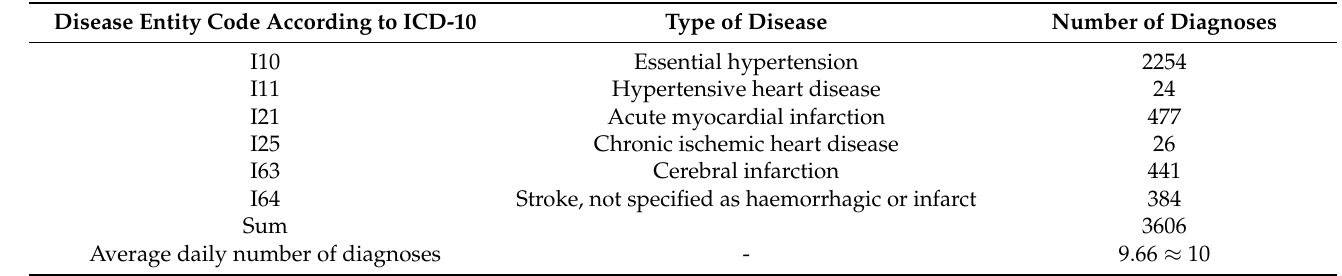
Table 2. List of disease entities included in the analysed group of diseases of the cardiovascular system, along with their ICD-10 codes and the number of